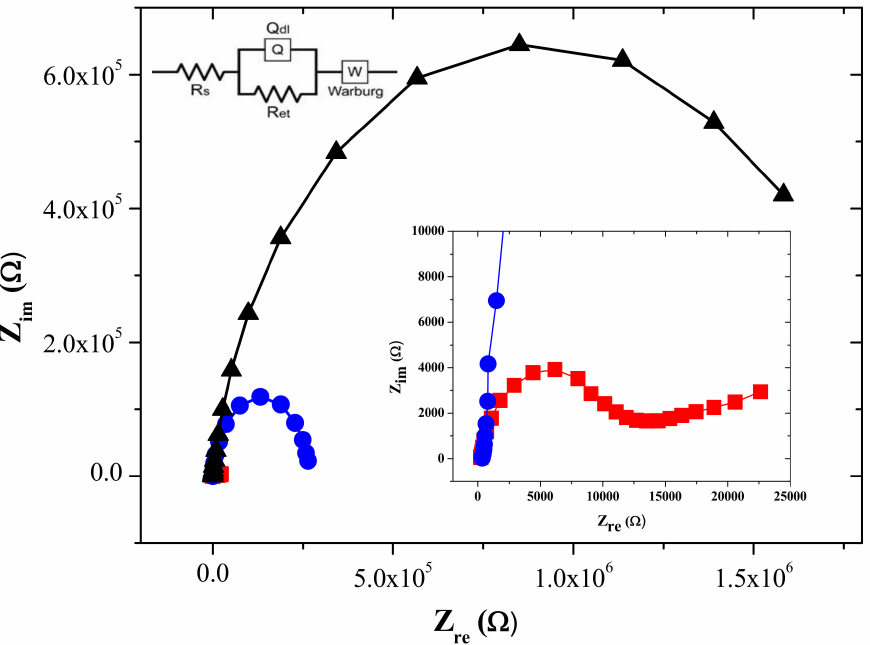
Figure 3. Nyquist plots for the impedance measurements in the presence of 5.0 mM K 3 Fe(CN) 6 /K 4 Fe(CN) 6 in 0.05 M PBS (pH 7.0) by the titania-Nafion composite-modified (black), graphene-titania-Nafion composite-modified (red), and CNT-titania-Nafion composite-modified (blue) GC electrode. Inset: four-component equivalent circuit R(QR)W, R et : electron transfer resis- tance, R s : solution resistance, Q dl : double-layer capacitance, W: Warburg